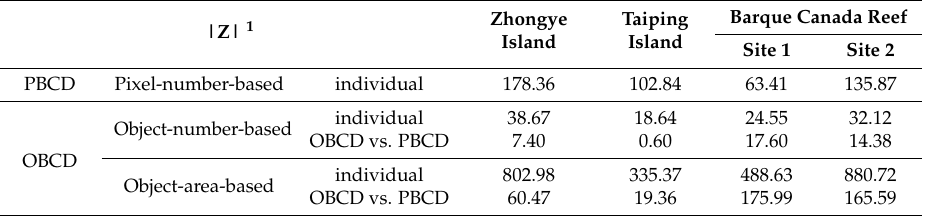
Barque Canada Reef Taiping Zhongye Island Island Site 1 Site 2